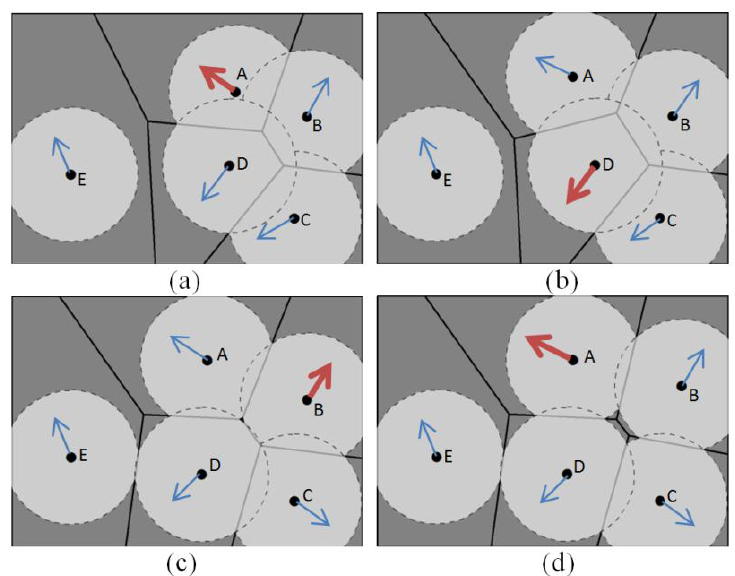
Figure 5. Simplified simulation of one round of the proposed algorithm to deploy five sensors. Red vector represents the move direction of the sensor with best priority to move in each step. (a),(b),(c), and (d) represent four steps of one